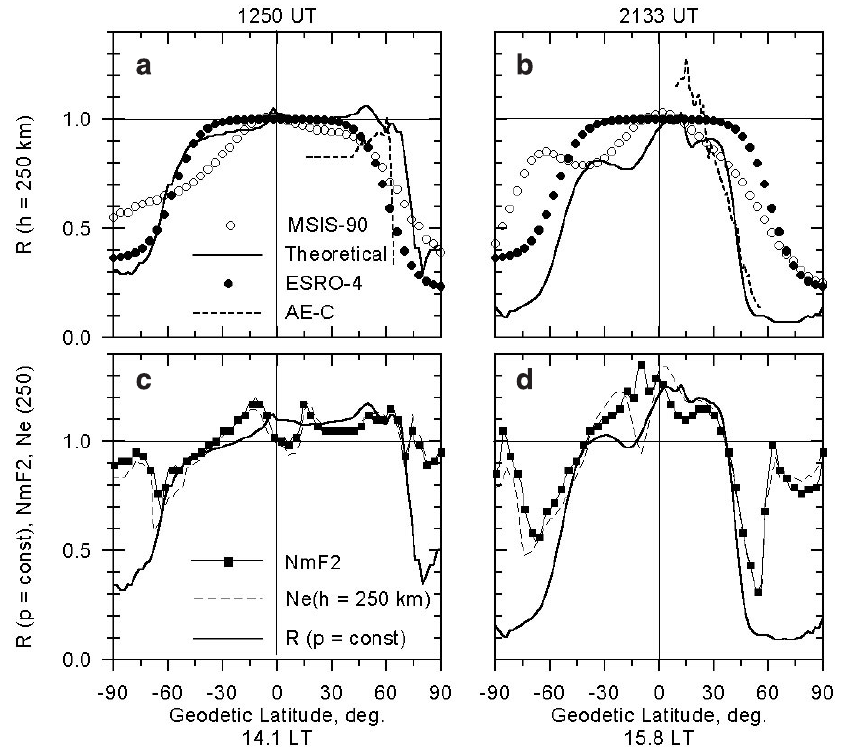
Fig. 10a–d. The thermospheric composition ratio ( solid lines ) R (O/N ) is shown both for 2 a fixed altitude of 250 km ( a , b ) and for a near constant pressure level at 1.3 · 10 ) 5 Pa ( c , d ). Comparison with observations ( upper panels ) is made for two di(cid:128)erent UT according to AE-C satellite overflights at local afternoon near 4.1 LT (19 (cid:176) E) or 1250 UT, and b 15.8 LT (273 (cid:176) E) or 2133 UT. Shown are corresponding MSISE90 model values ( open circles ) and the AE-C measurements ( dashed lines ) re- duced to 250 km altitude while ESRO-4 data according to the statistical model of Zuzic et al . (1997) are at 280 km ( solid circles ). c , d . This shows the modelled storm- to-quiet ratios of electron density at 250 km altitude ( dashed ) and at the F -layer maxi- 2 mum ( N F , full squares) (taken from m 2 Fo¨ rster et al